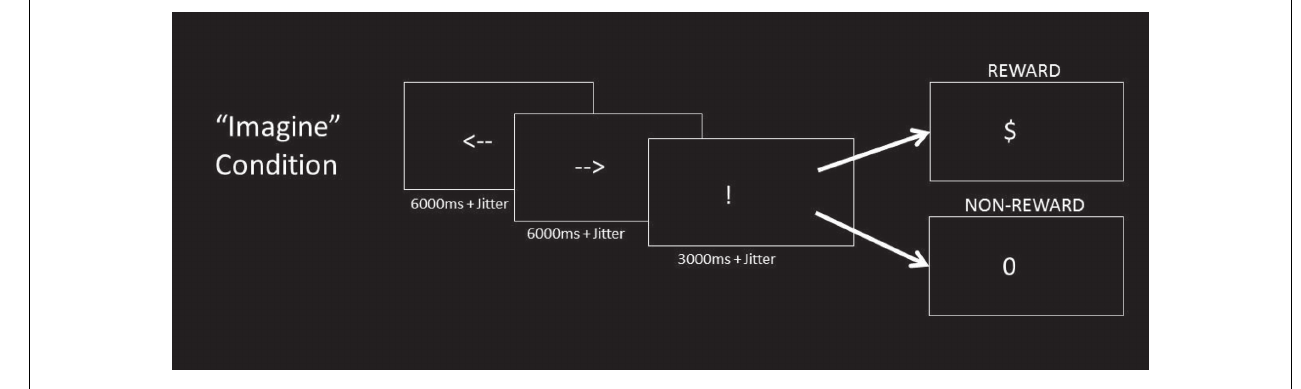
choice. One of the two options was rewarded action, and the other would be unrewarded action.The rewarded action response in the preceding trial was more likely to be rewarded action in the current trial. Participants received either rewarded (“$”) or non-rewarded (“0”) feedback as a result of their choice.The response cue and outcome cues were identical to the Imagine